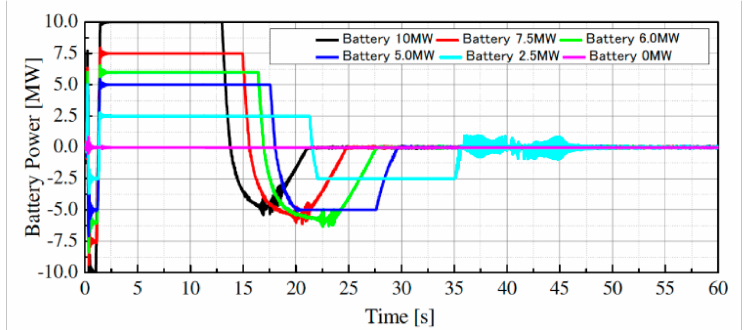
Figure 25. Battery output (II) (Pumping